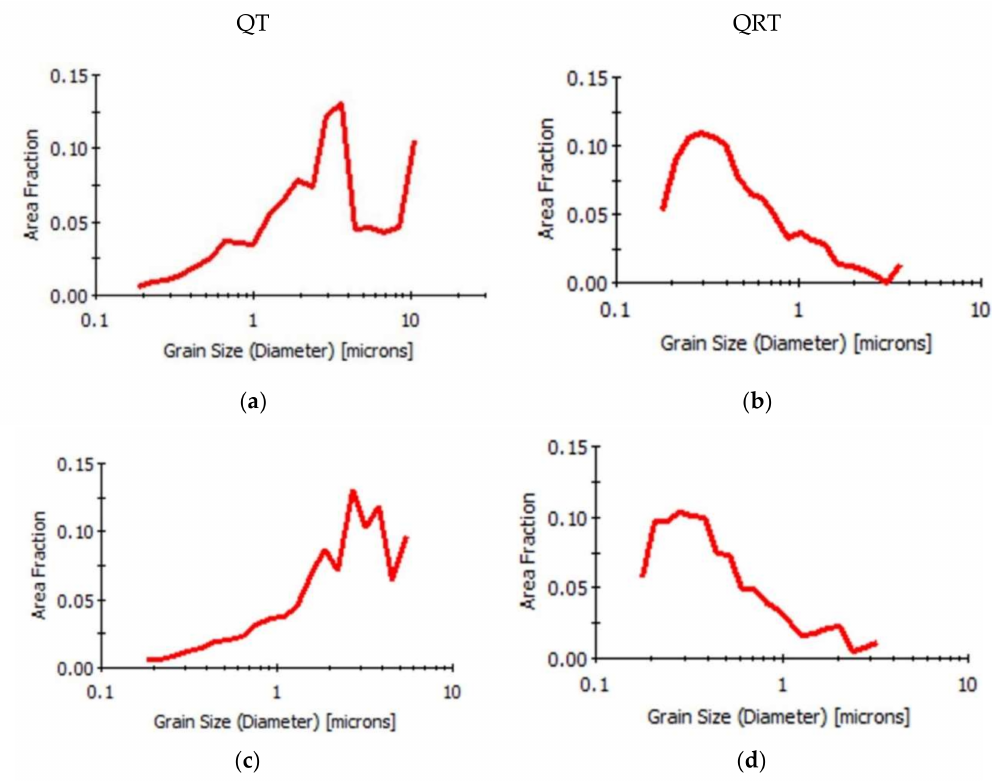
Figure 12. Grain size measured from EBSD maps for grains separated by boundaries with misorientation > 1 ◦ : ( a ) 0Cu QT; ( b ) 0Cu QRT; ( c ) 1.5Cu QT; ( d ) 1.5Cu QRT. Map step was 0.05 µ